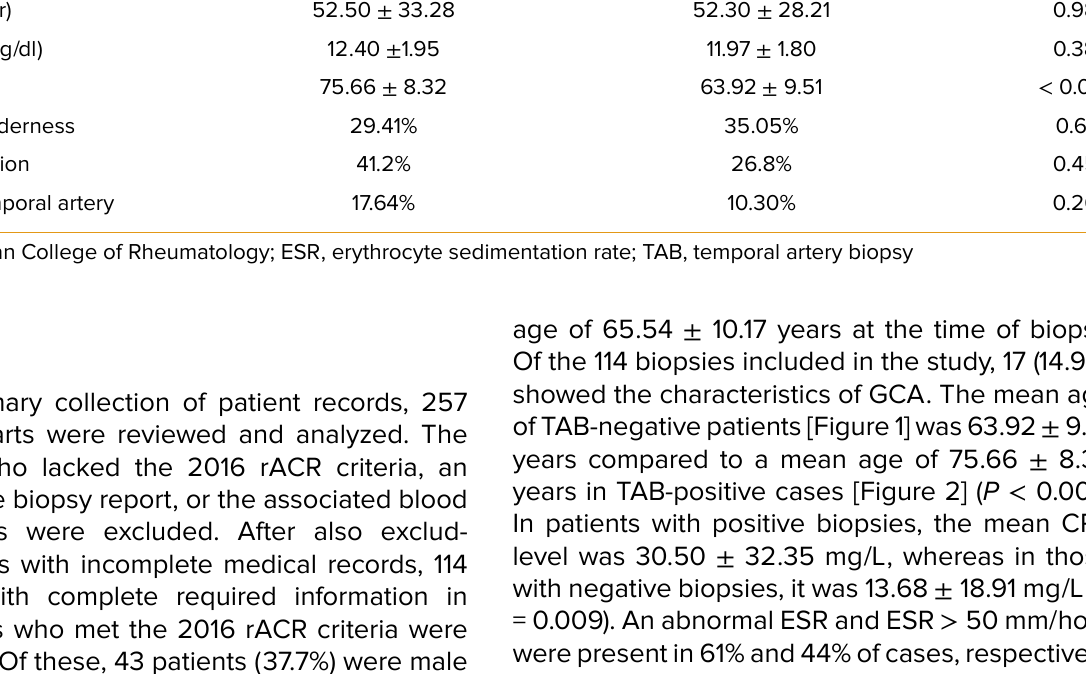
TAB-positive (n = 17) TAB-negative (n =